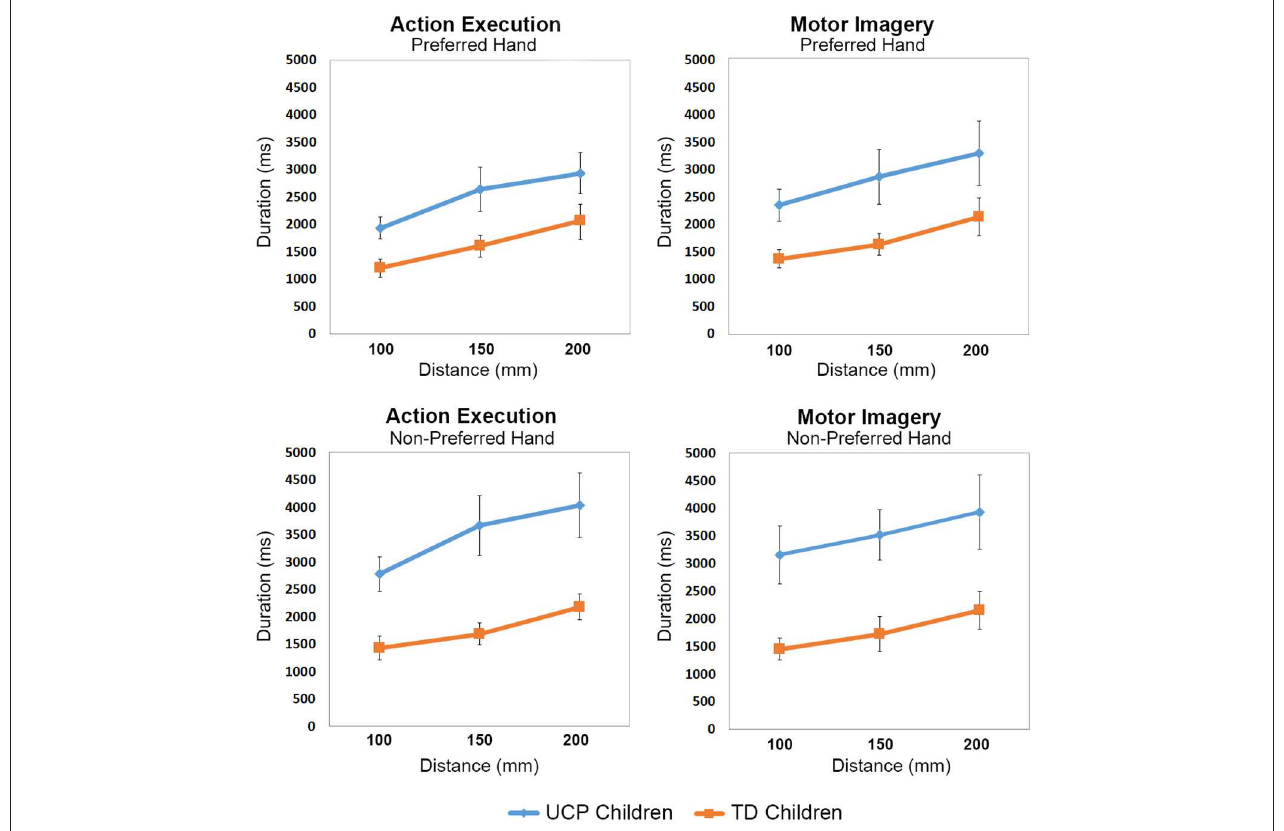
FIGURE 2 | Line graphs showing mean movement durations (ms) with increased Distances for each group of participants.